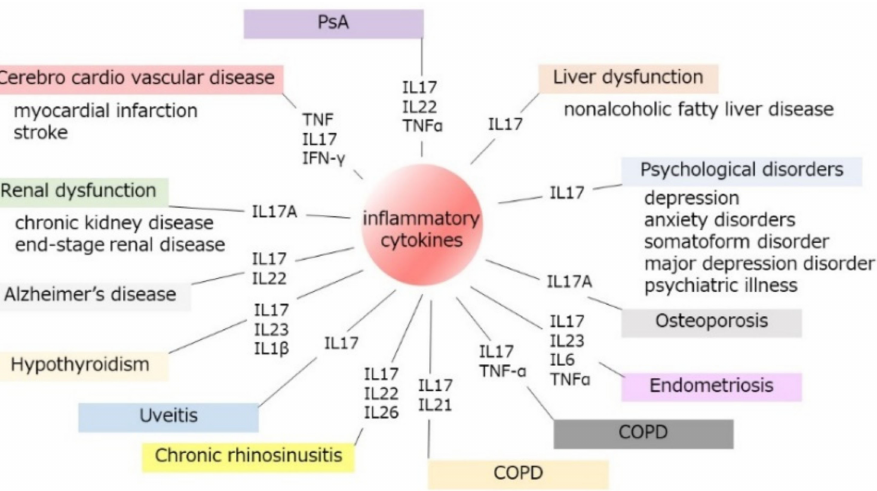
Figure 2. Interactions of psoriatic inflammation to systemic inflammatory disorders. Psoriatic inflammation is involved in the development of systemic organ dysfunctions. As skin occupies a large surface field in the human body, the characteristics of psoriasis as large surface involvement influences the extension of abundant inflammatory involvement in systemic inflammatory